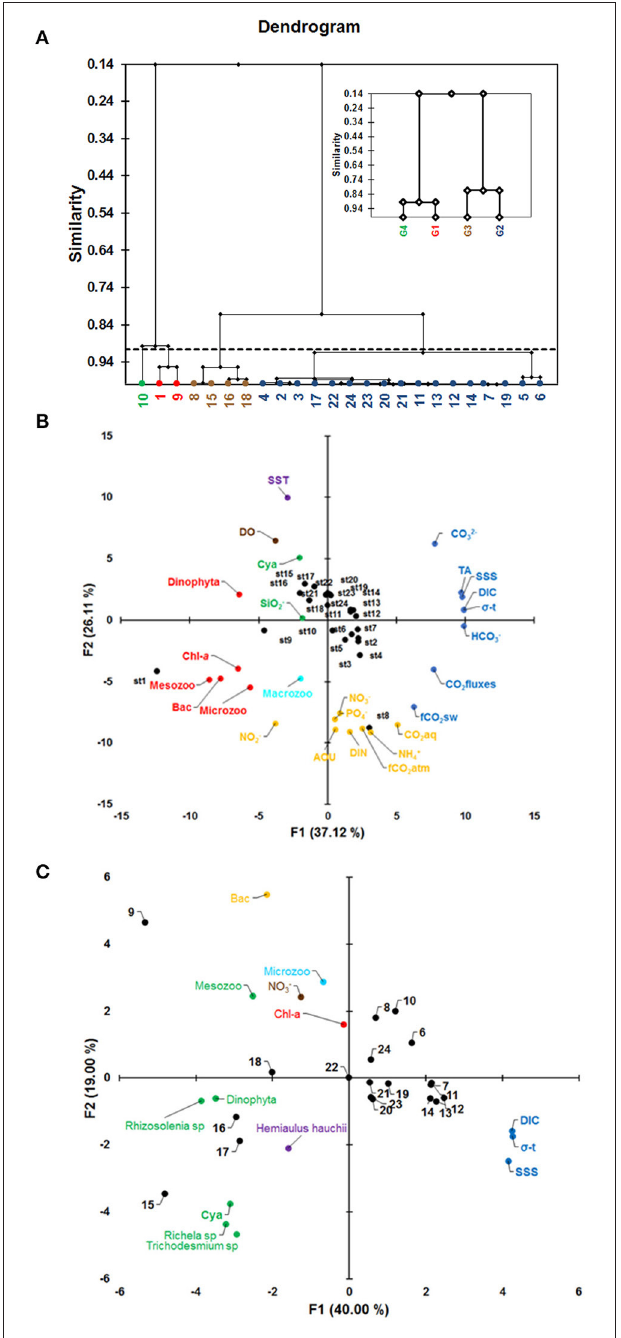
FIGURE 8 | (A) Clustering diagram (G1 = group 1, in red color; G2 = group 2, in blue color; G3 = group 3, in brown color and G4 = group 4, in green color); (B) Principal component analysis (PCA) with all variables found along the full ship track during the CF3 cruise, October 2012; and (C) PCA with biological groups in the offshore NECC region. The acronyms correspond to those specified in Table 1 for PCA analysis.